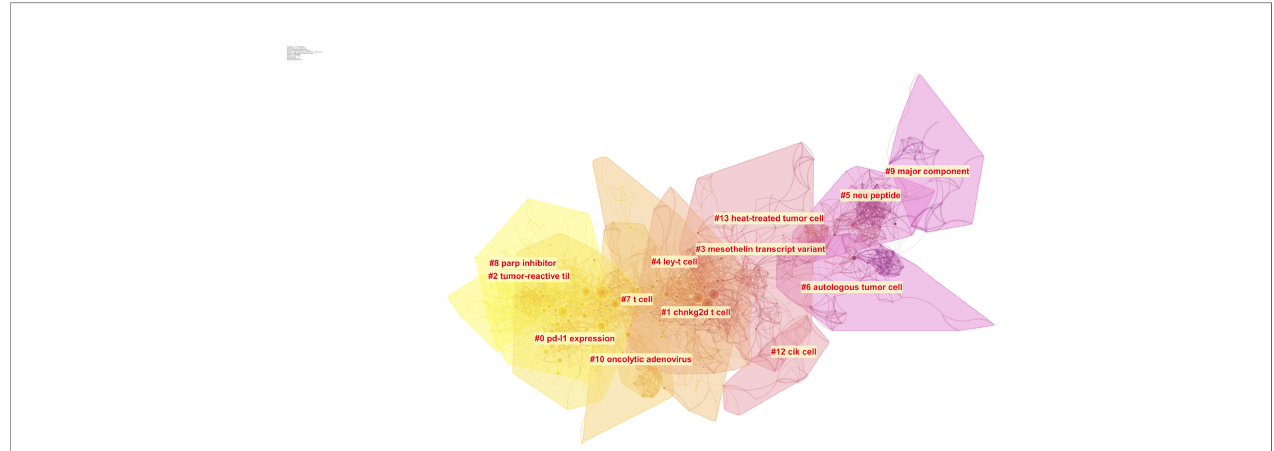
FIGURE 4 | Clustering of the co-citation network of the references. The color represents different cluster, colors vary from yellow to pink represent the prevalence time, The closer yellow represents the closer cluster prevalence time to the present, the closer pink the opposite.